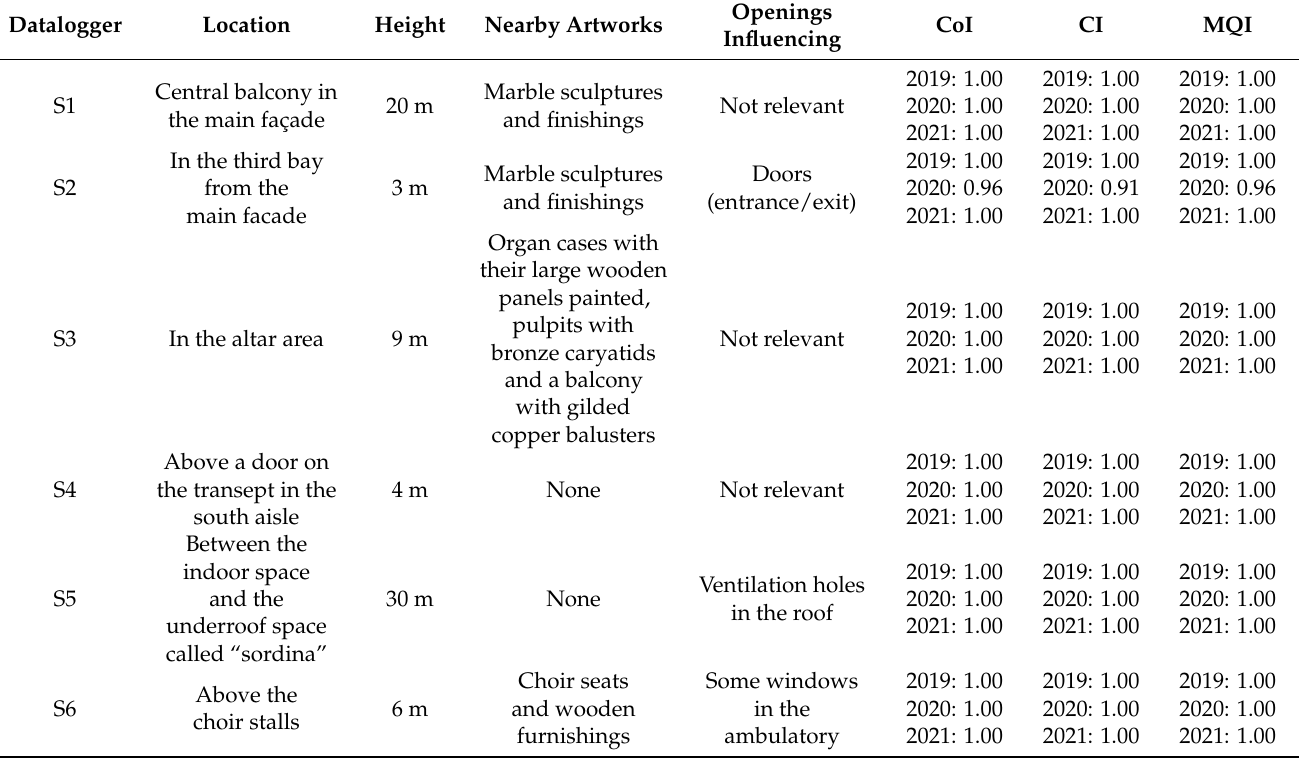
Table 1. Main information on the dataloggers adopted for the monitoring